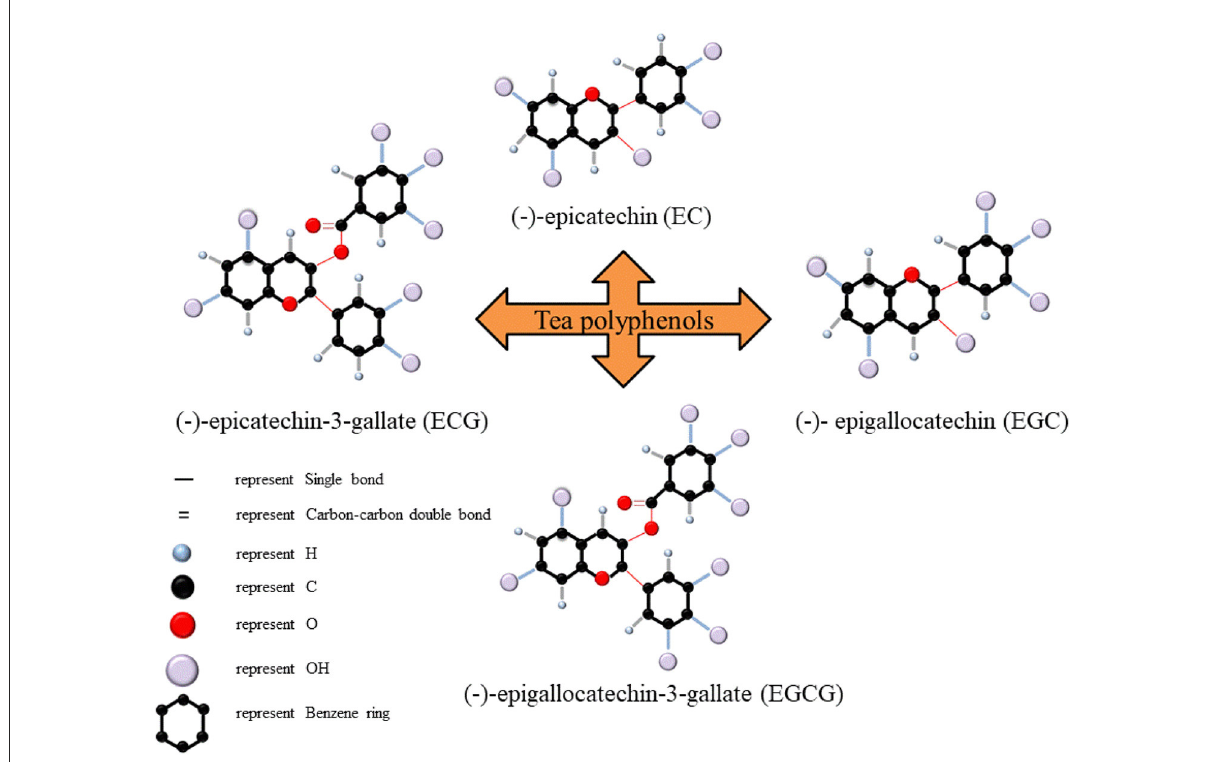
FIGURE2 The main structure of tea